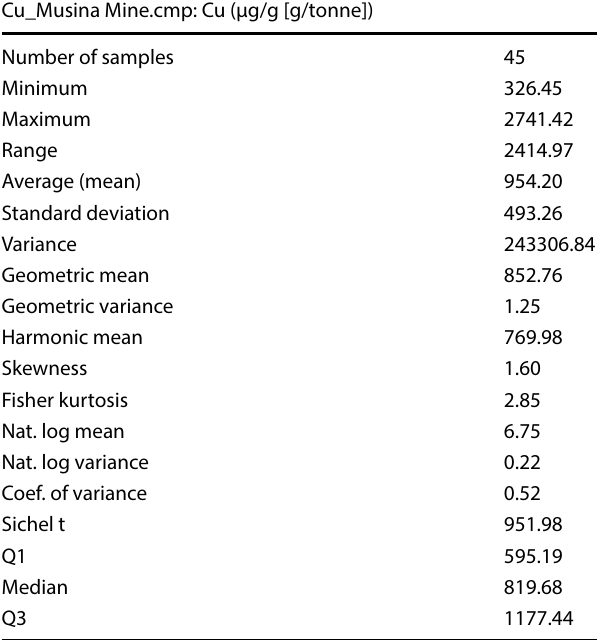
Table 3 Musina Copper Mine dump: Cu general statistics in µg/g (g/tonne)